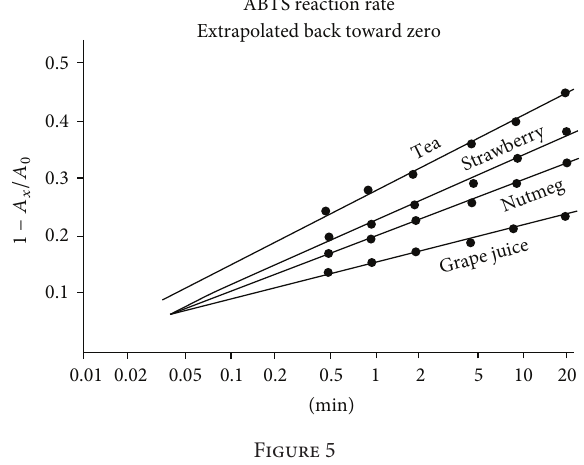
Table 2: Pulps and peels.